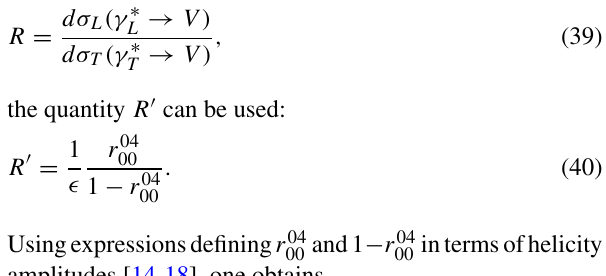
Table 3 W dependence of SDMEs r 1